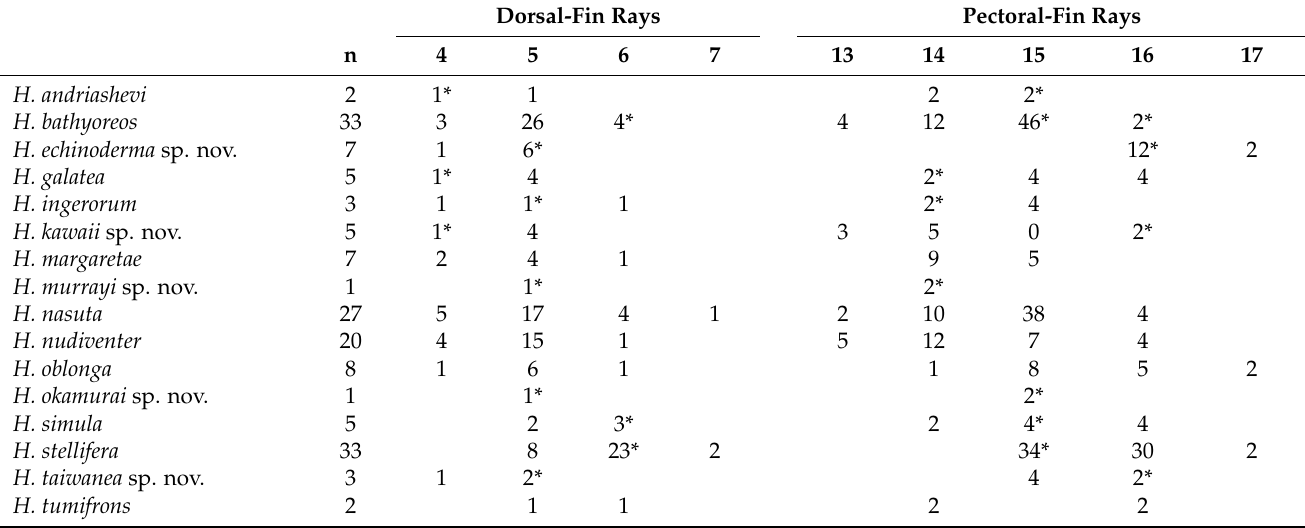
Table 1. Frequency of dorsal- and anal- fin rays in all Halieutopsis species in present study. Pectoral-fin rays were counted on both sides. * denotes value of holotype. Dorsal-Fin Rays Pectoral-Fin Rays n